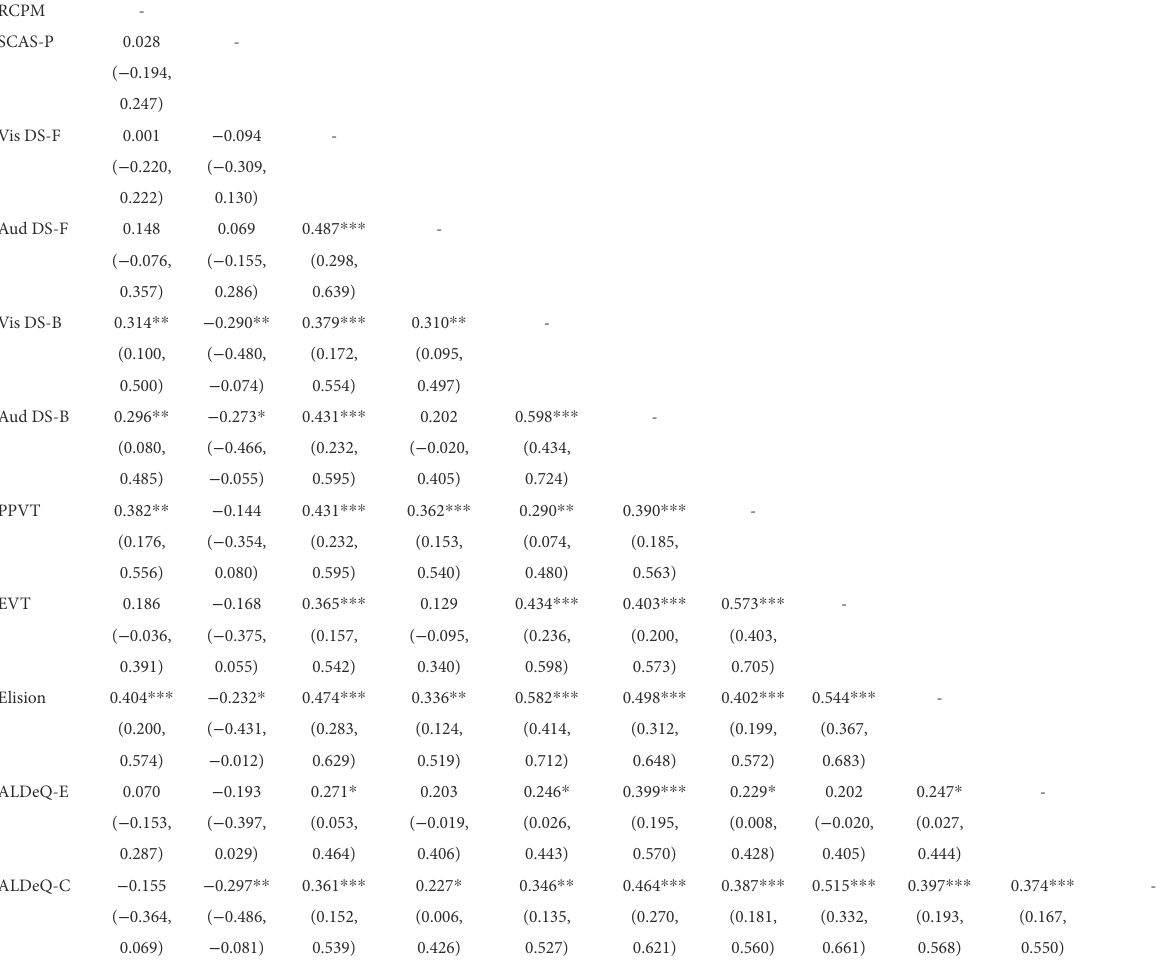
TABLE 3 Partial correlations (and 95% CI) between all measures. RCPM